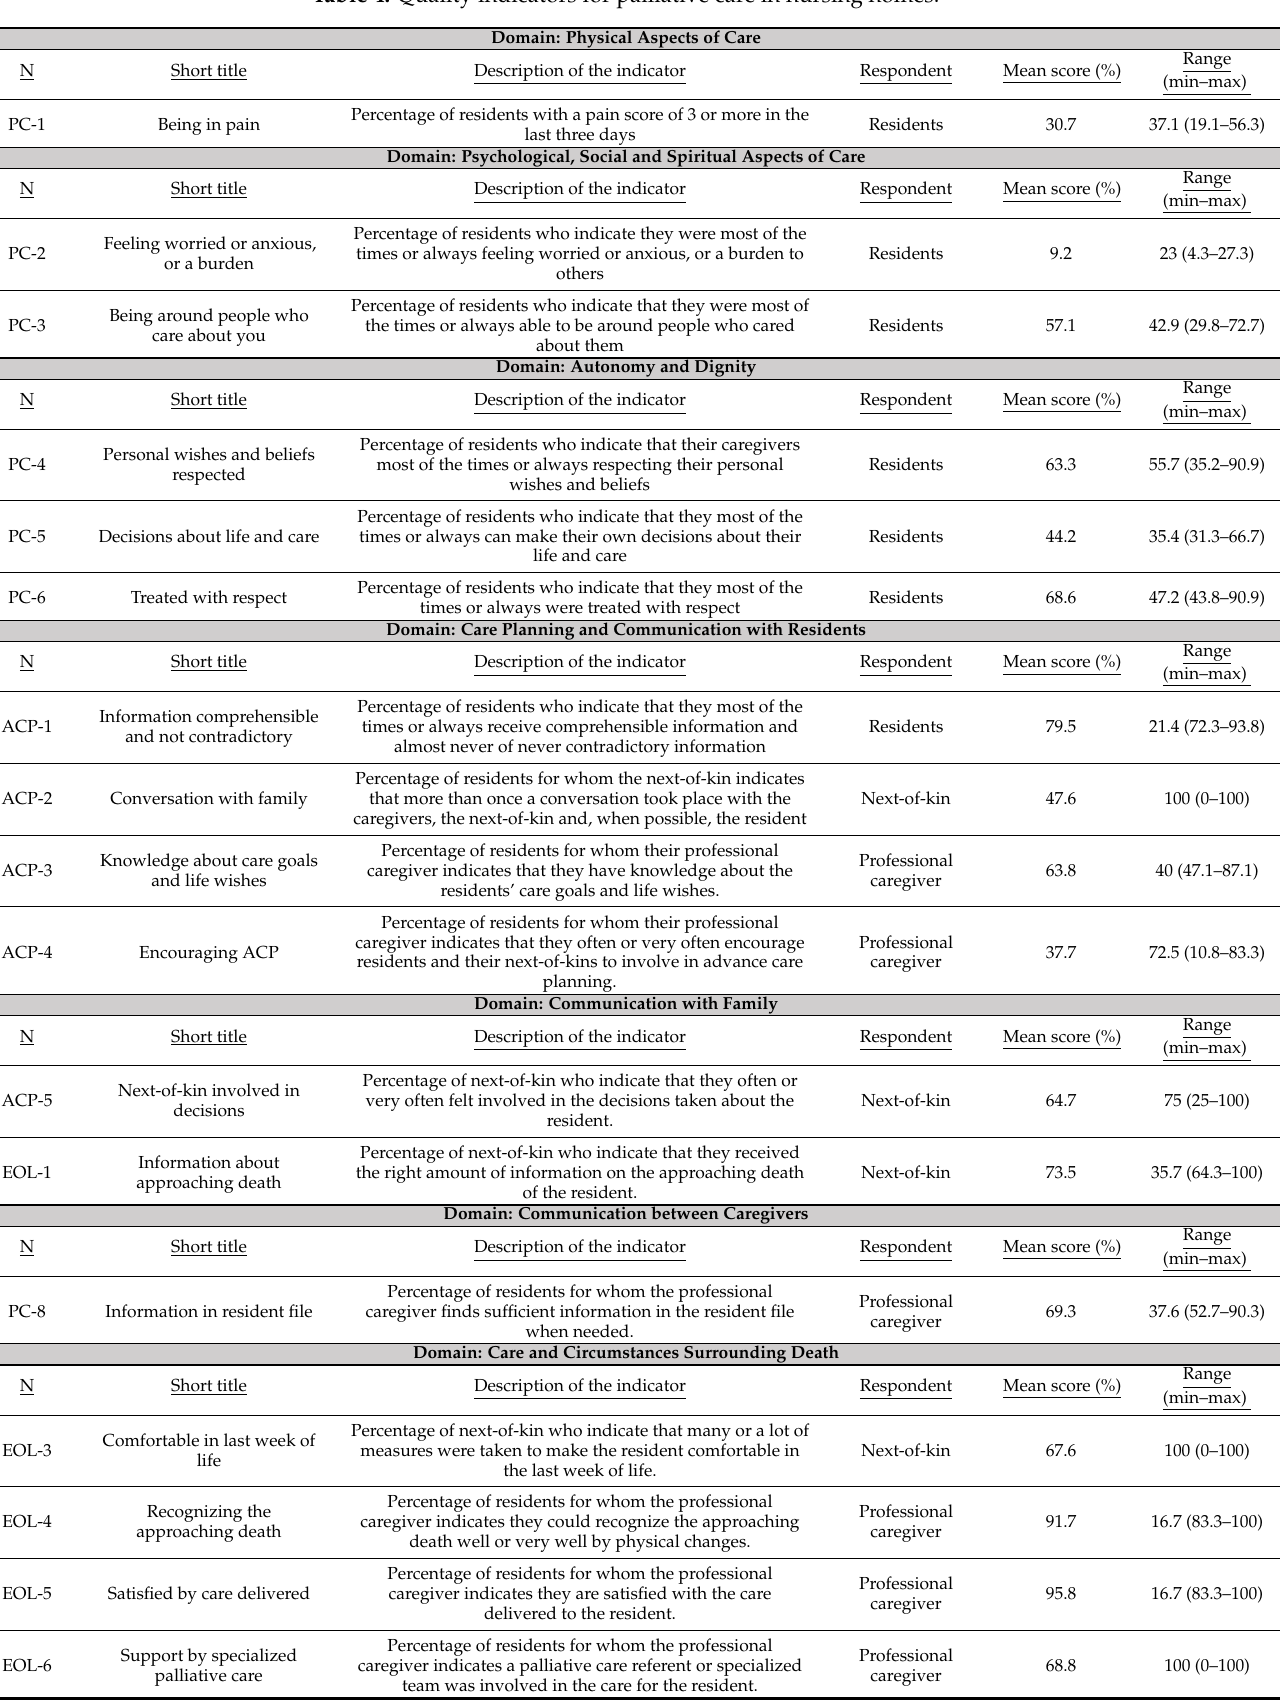
Table 4. Quality indicators for palliative care in nursing